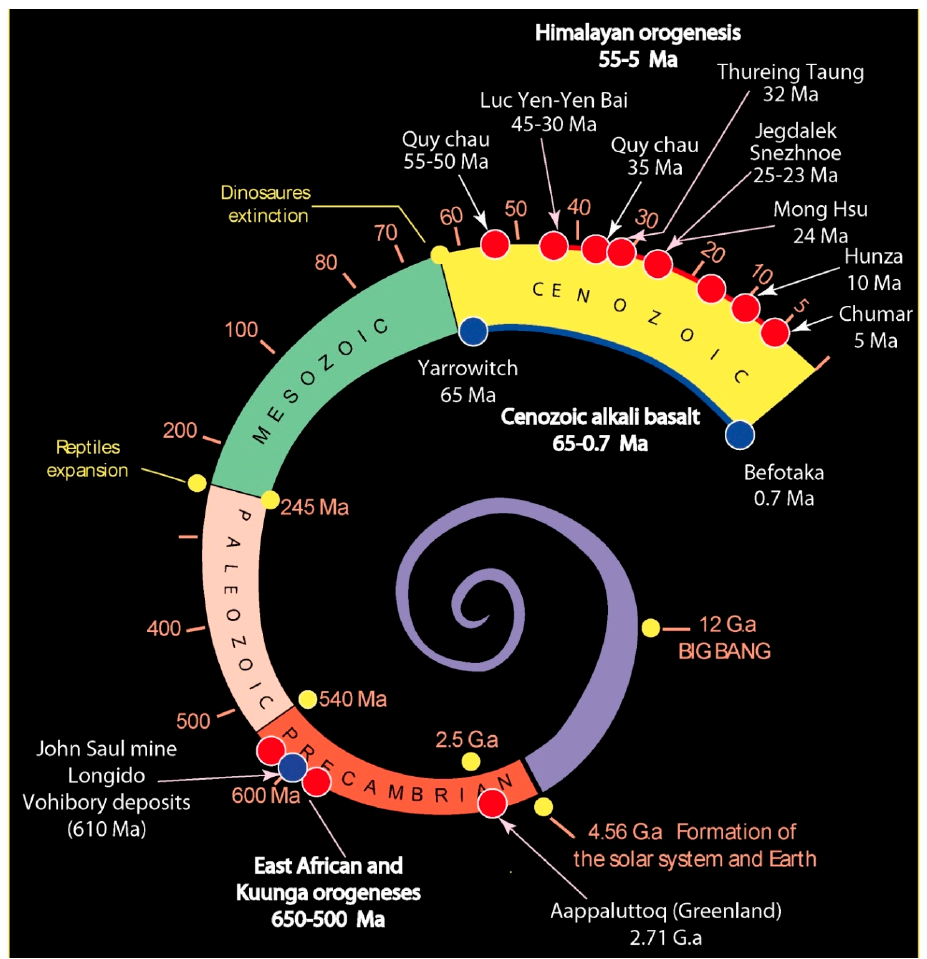
Figure 22. The spiral time diagram of corundum formation that includes economic ruby (and sapphire) deposits. Four main economic corundum periods have been defined worldwide by different methods of indirect dating of corundum. The oldest deposit is Aappaluttoq in Greenland where the ruby formed during the Archean at 2.71 Ga. The main period of gem rubies formation was the Pan-African orogeny (750–450 Ma). This includes primary ruby deposits in the Pan-African tectonic-metamorphic belt such as the John Saul mine in Kenya, Longido in Tanzania, and the deposits of Southern Madagascar, all formed at around 610 Ma. The third period corresponds to the Cenozoic Himalayan orogeny (55 Ma to the Quaternary) with the famous marble-hosted ruby deposits in Central and South-East Asia as in the deposits of Thureing Taung at Mogok and Mong Hsu in Myanmar [88]. The fourth period is dominated by the extrusion of alkali basalts in the Cenozoic (65 Ma to Quaternary) where ruby (and sapphire) were transported as xenocrysts or in xenoliths by the magmas. The age of the parental rocks of the ruby is unknown but a metamorphic origin is preferentially evidenced. Most of the ages are minimum cooling ages except those obtained on zircon by the U/Pb method.